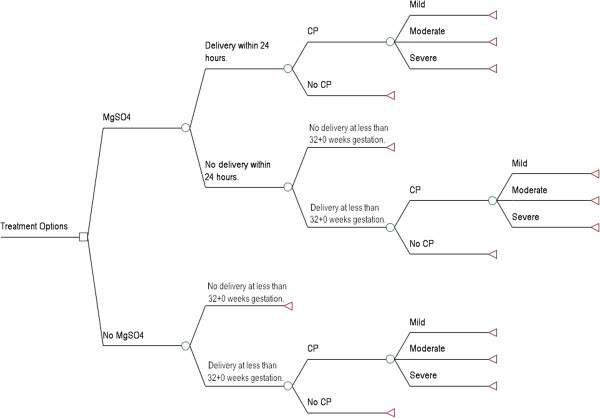
Decision tree for the threatened preterm birth models. The decision tree used to compare standard care (no treatment) with administration of magnesium sulphate to patients in whom preterm birth at < 32+0 weeks gestation is threatened.